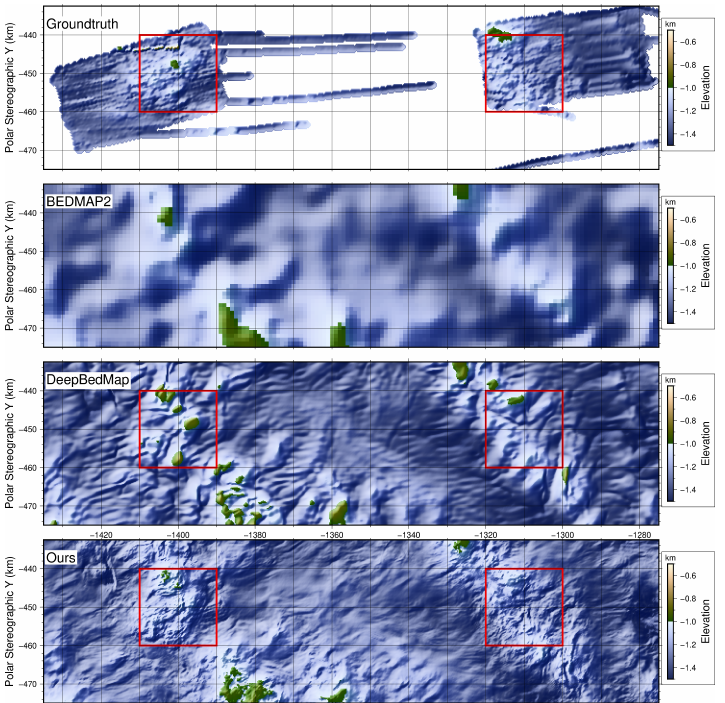
Figure 5. Comparison of bed elevation grid products over Thwaites Glacier. The ground-truth is from gridded Operation IceBridge points. Red boxes show the locations of the obvious differences between the above topographies.